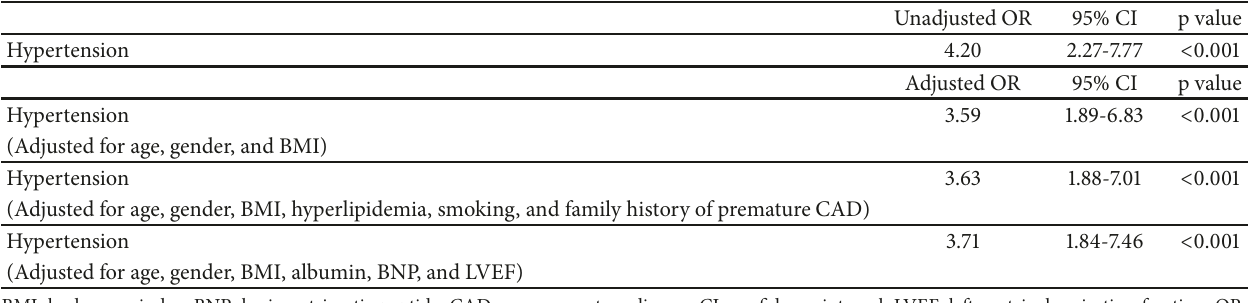
Table 5: Hypertension for prediction of multivessel coronary artery disease based on multivariable logistic regression models (n=187).